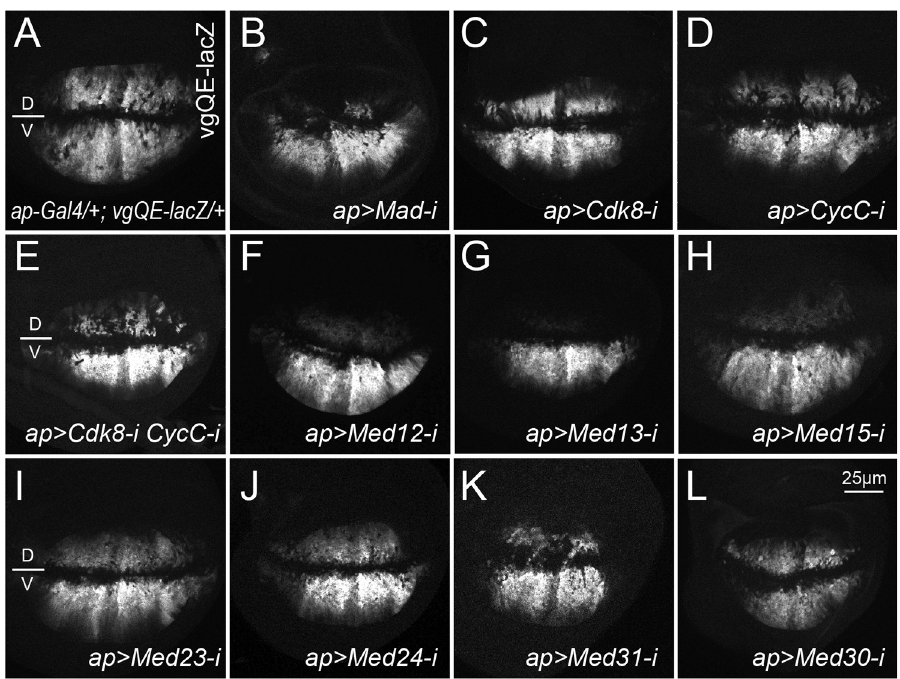
Fig 6. Effects of various Mediator subunits on the expression of the vgQE-lacZ reporter. Representative confocal images of anti- β -Gal staining of wing discs of the following genotypes: (A) ap-Gal4/+; vgQE-lacZ/+; (B) ap-Gal4/+; vgQE-lacZ/UAS-Mad-RNAi (BL-31315); (C) ap-Gal4/+; vgQE-lacZ/UAS-Cdk8-RNAi ; (D) ap-Gal4/+; vgQE-lacZ/ UAS-CycC-RNAi ; (E) ap-Gal4/+; vgQE-lacZ/UAS-Cdk8-RNAi CycC-RNAi ; (F) ap-Gal4/+; vgQE-lacZ/ UAS-Med12-RNAi ; (G) ap-Gal4/+; vgQE-lacZ/UAS-Med13-RNAi ; (H) ap-Gal4/+; vgQE-lacZ/UAS-Med15-RNAi ; (I) ap-Gal4/+; vgQE-lacZ/UAS-Med23-RNAi ; (J) ap-Gal4/+; vgQE-lacZ/UAS-Med24-RNAi ; (K) ap-Gal4/+; vgQE-lacZ/ UAS-Med31-RNAi ; (L) ap-Gal4/+; vgQE-lacZ/UAS-Med30-RNAi . At least five wing discs were examined for each genotype. Scale bar in L: 25 μ m.